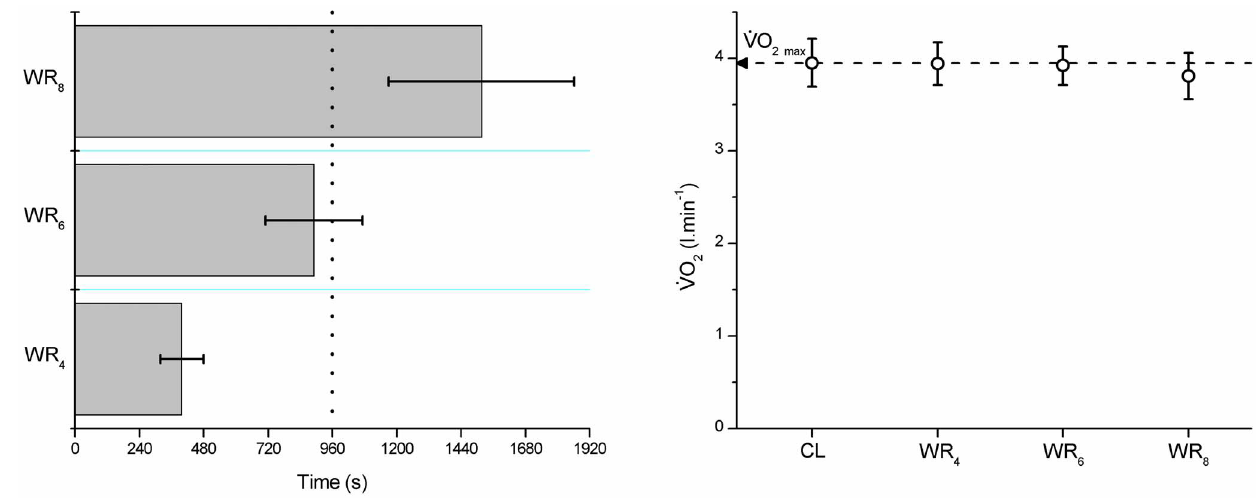
Figure 3. Left panel: The tolerable duration of HIIT at WR 4 , WR 6 and WR 8 (i.e. the work rate interpolated from the Speed-tolerable duration relationship to induced exercise intolerance in 4 min, 6 min and 8 min if performed at a constant speed), relative to the target HIIT duration of 960 s (i.e. 4 6 4 min; dotted vertical line). Right panel: The corresponding _ VVO 2 attained at exercise intolerance during HIIT at WR 4 , WR 6 and WR 8 , relative to _ VVO 2 max (dotted line), and that attained in the constant-speed (CL) tests. Note _ VVO 2 max was attained in all protocols, although _ VVO 2 during HIIT at WR 8 was slightly (insignificantly) lower due to some subjects being able to complete the maximum 8 bouts. doi:10.1371/journal.pone.0076420.g003 PLOS ONE |